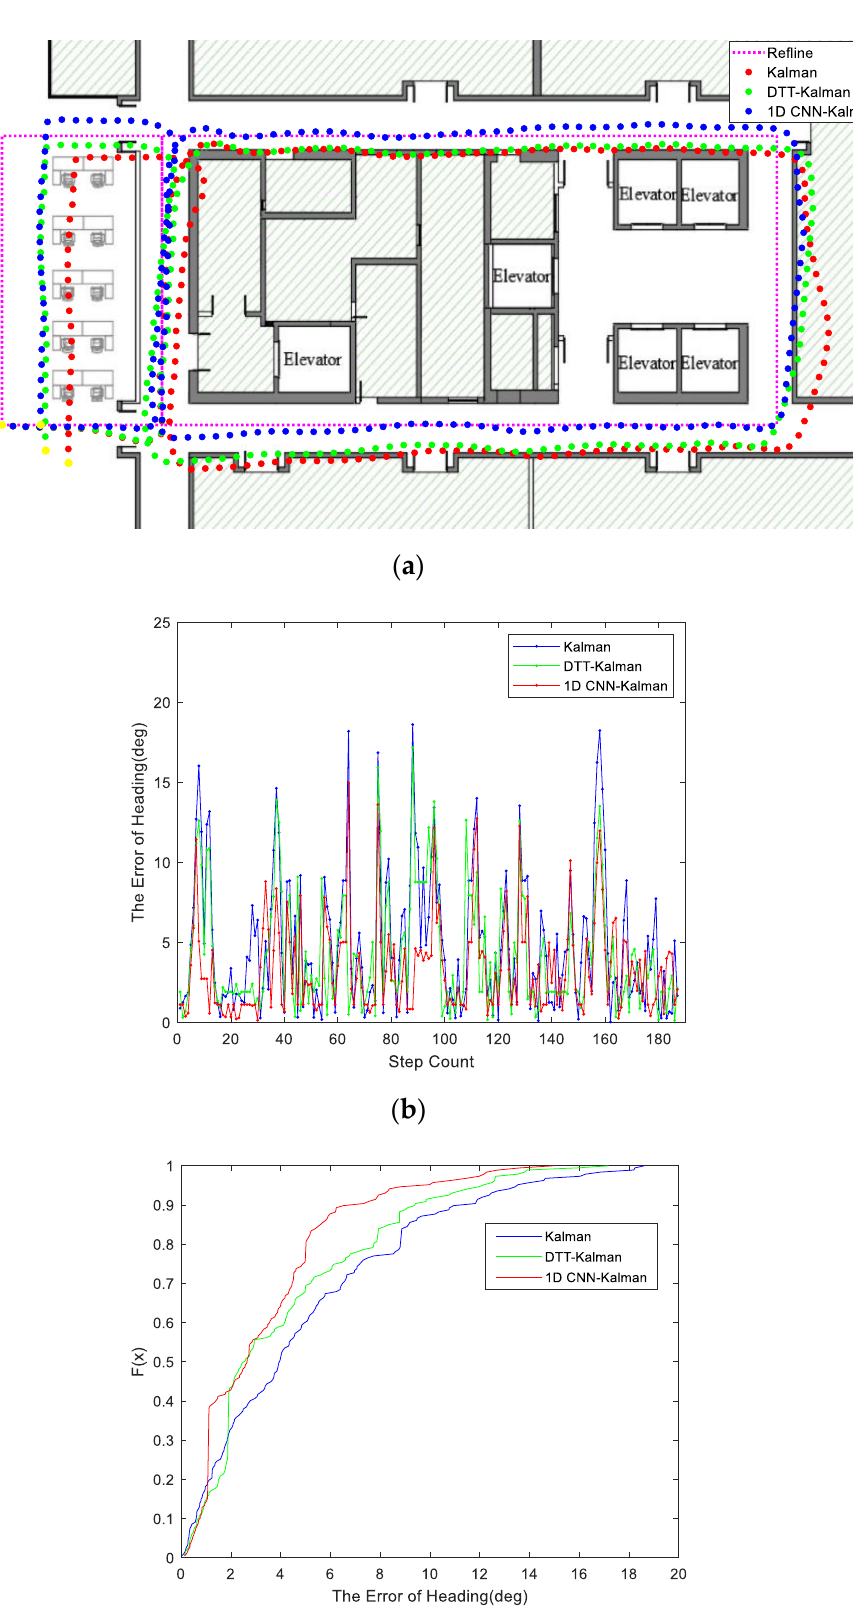
Figure 7. ( a ) The results of the trajectory test using three different algorithms for indoor pedestrian inertial navigation. ( b ) The error of the heading angle for the three algorithms. ( c ) The cumulative distribution function (CDF) of the heading estimation error based on the three algorithms.